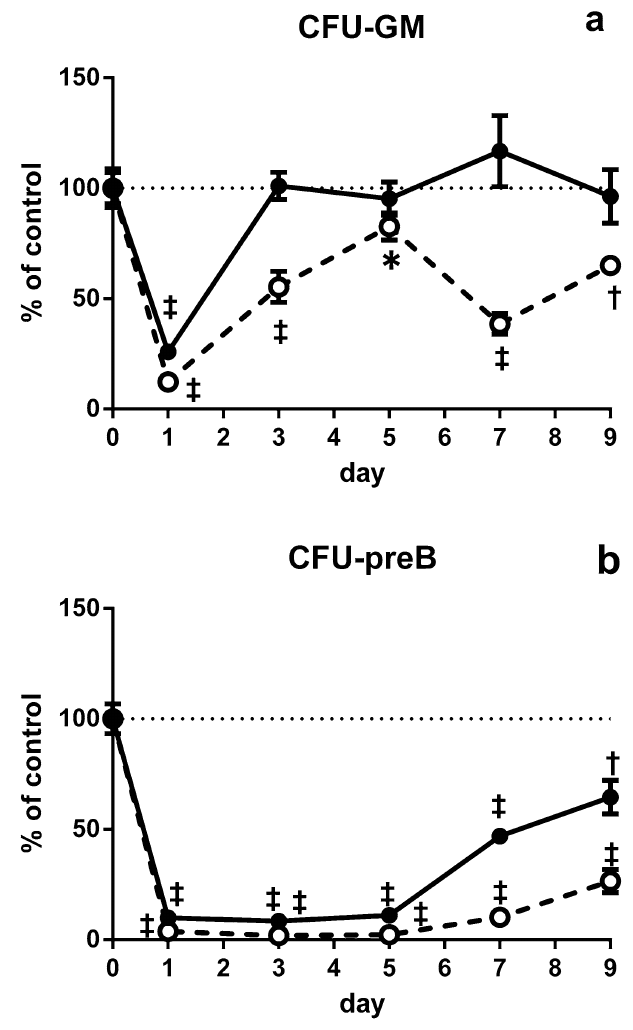
Figure 2. Changes in the numbers of hematopoietic progenitor cells in BM after LPS treatment. Changes in the numbers of hematopoietic progenitor cells in the BM of young and aged SAMP1/TA-1 mice after LPS treatment are shown. Changes in the numbers of CFU-GM ( a ) and CFU-preB ( b ) in young (closed circles) and aged (open circles) SAMP1/TA-1 mice after intravenous injection of 25 μg LPS are shown. Samples of femoral BM were obtained from three mice per group at each time point (1, 3, 5, 7, and 9 days) after treatment with LPS. The results are expressed as the percentage of control. Each bar represents the mean ± S.D. *P < 0.05, † P < 0.005, ‡ P < 0.001 vs. saline-treated